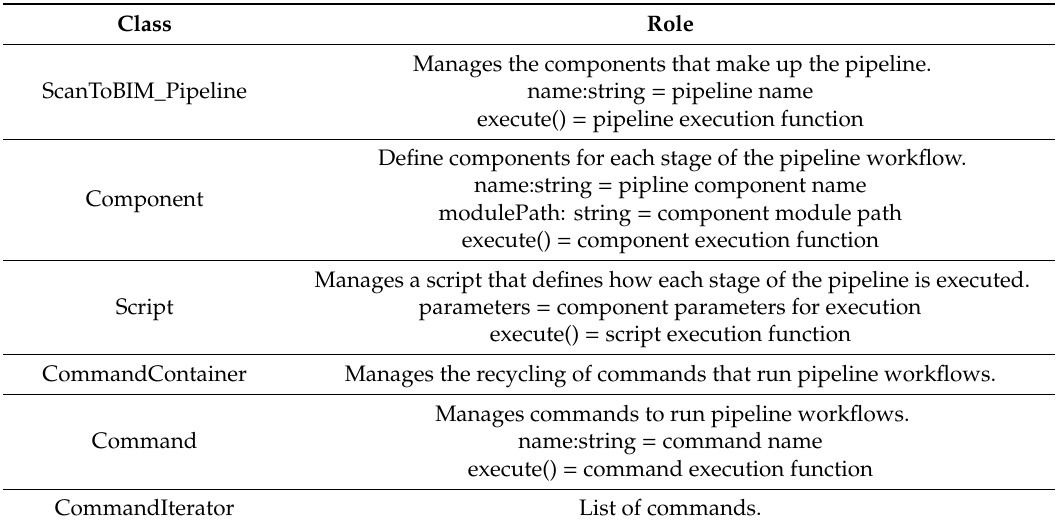
Figure 6. Scan-to-BIM Pipeline Architecture (UML). Table 2. Scan-to-BIM class role definition.